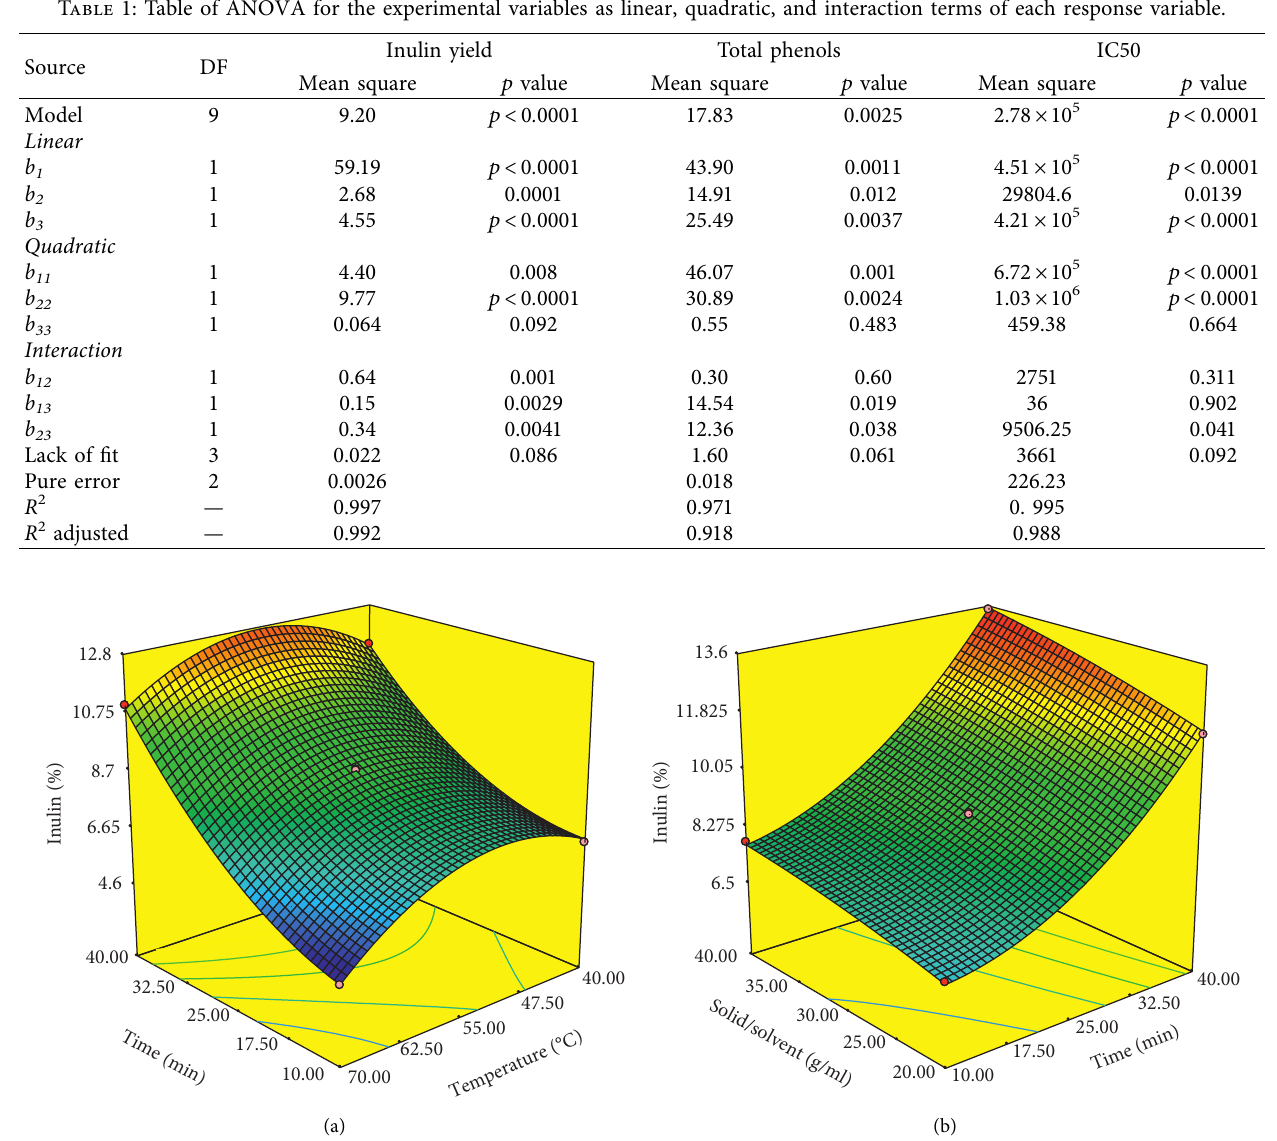
Figure 3: Response surface for the effect of (a) sonication time and sonication temperature (water/solid � 1 :30g/ml) and (b) sonication time and water/solid ratio (sonication temperature � 55 ° C) on the yield of